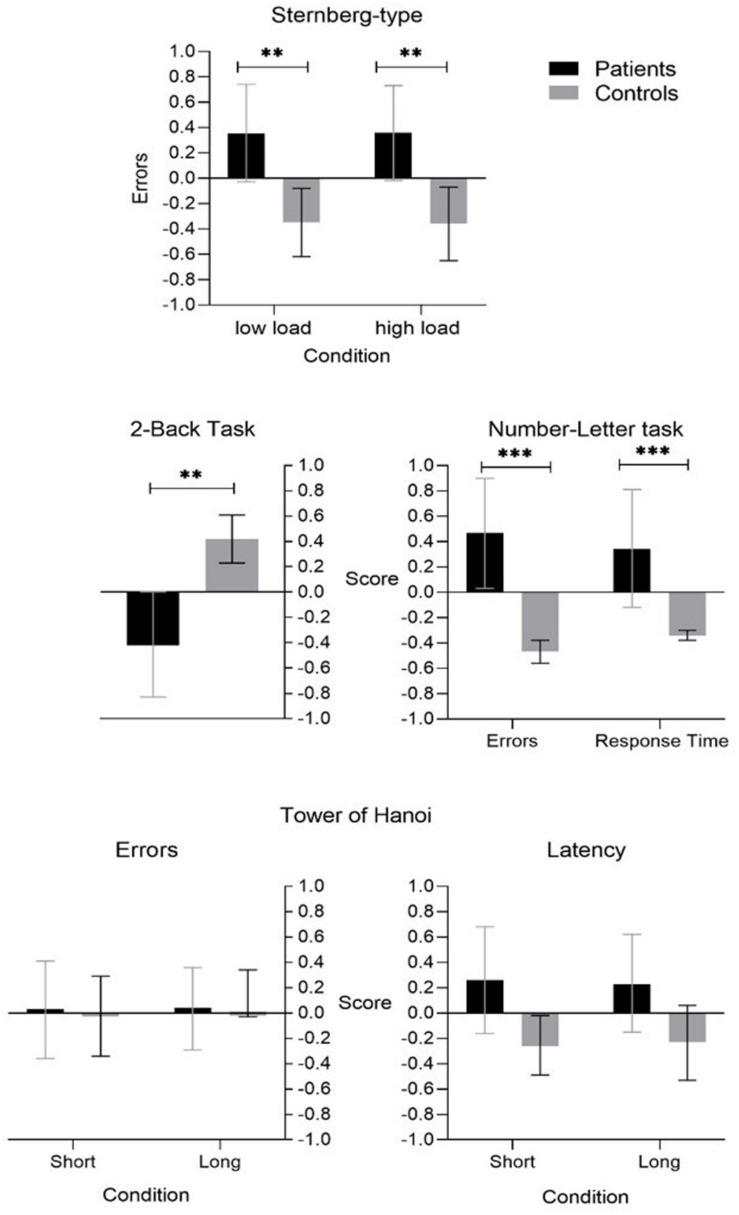
Cool Executive Functions tasks. **p < 0.01, ***p < 0.001.